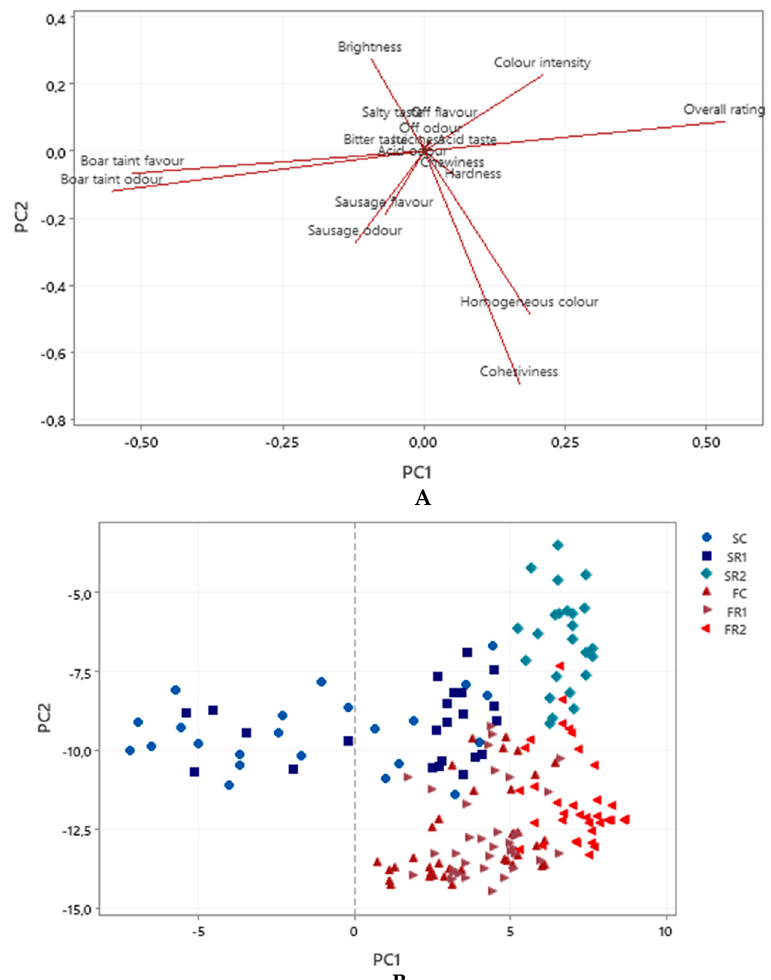
Figure 2. Principal components analyses of sensory test attributes. ( A ): projection of the sensory attributes analyzed. ( B ): projections on the Frankfurt (F) and Spanish (S) sausages with three formulations. C: control regular fat content; R1: fat reduced with inulin + β -glucan; R2: fat reduced with inulin + β -glucan + grape skin.